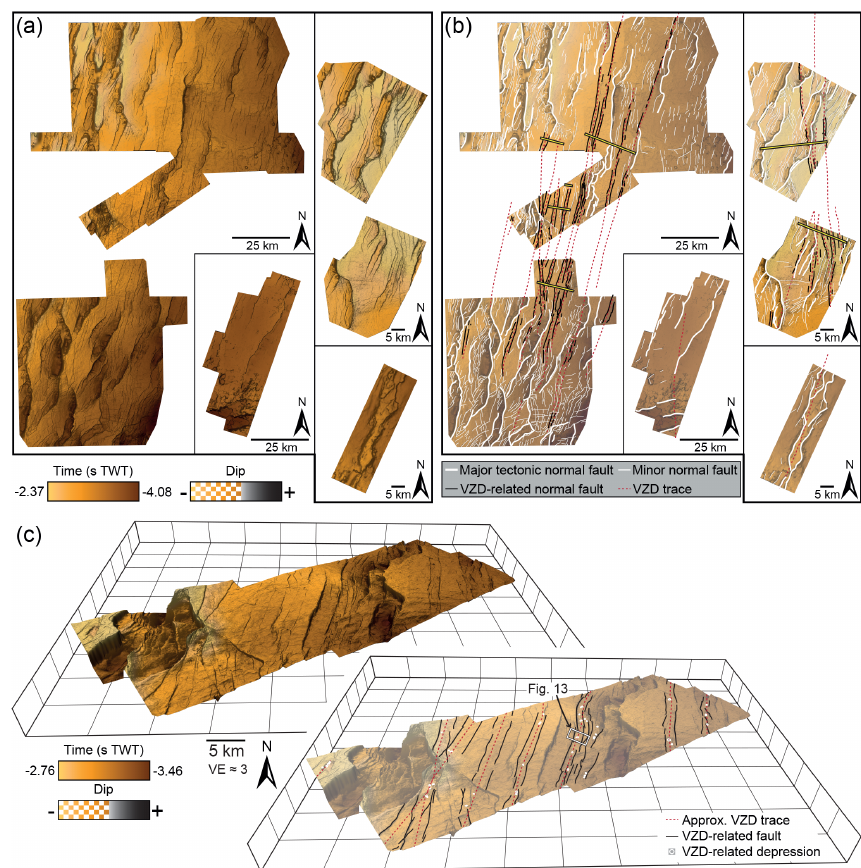
Figure 12. (a–b) Uninterpreted and interpreted time–structure maps showing that faults developed along the near Top Mungaroo Formation relative to the location of underlying VZD traces. Yellow bars in (b) correspond to seismic section locations in Figs. 6 and 7; see Fig. 4d for section labels. For clarity, down-throw markers are omitted. (c) Uninterpreted and interpreted 3D view of the near Top Mungaroo Formation in the Chando 3D survey. For clarity, only VZD-related normal faults are interpreted, in addition to underlying VZD traces and sub-circular depressions (i.e. VZD-related